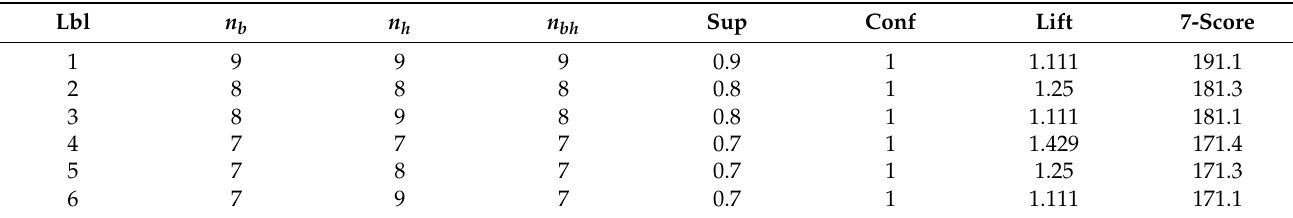
Table A1. Parameters and scores of the rules for the 10 × 10